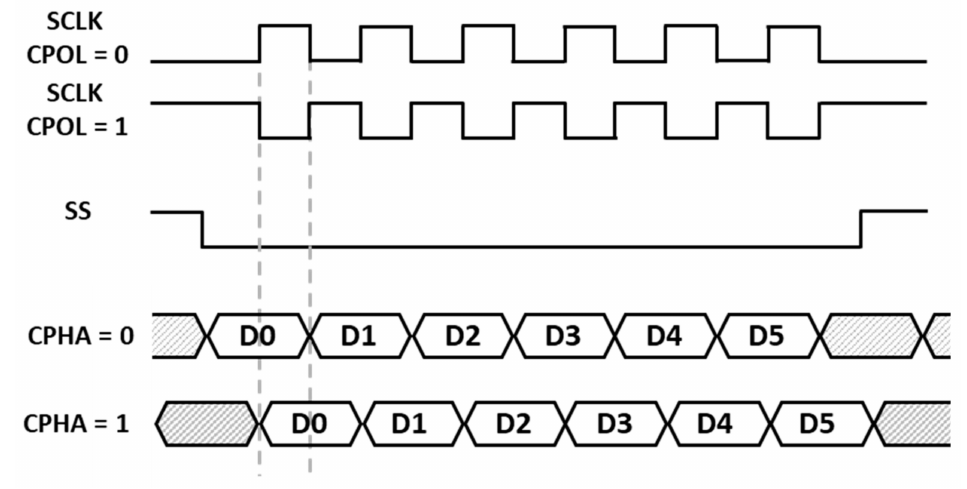
Figure 3. SPI clock polarity and clock phase (CPHA) working